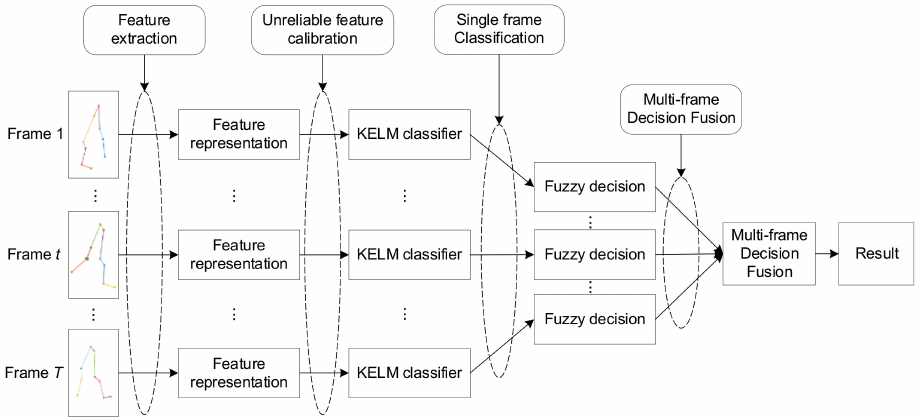
Figure 2. The flowchart of the proposed gait recognition